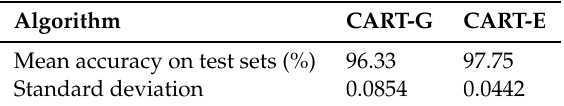
Table 3. Results of cross-validation approach for CART algorithms.